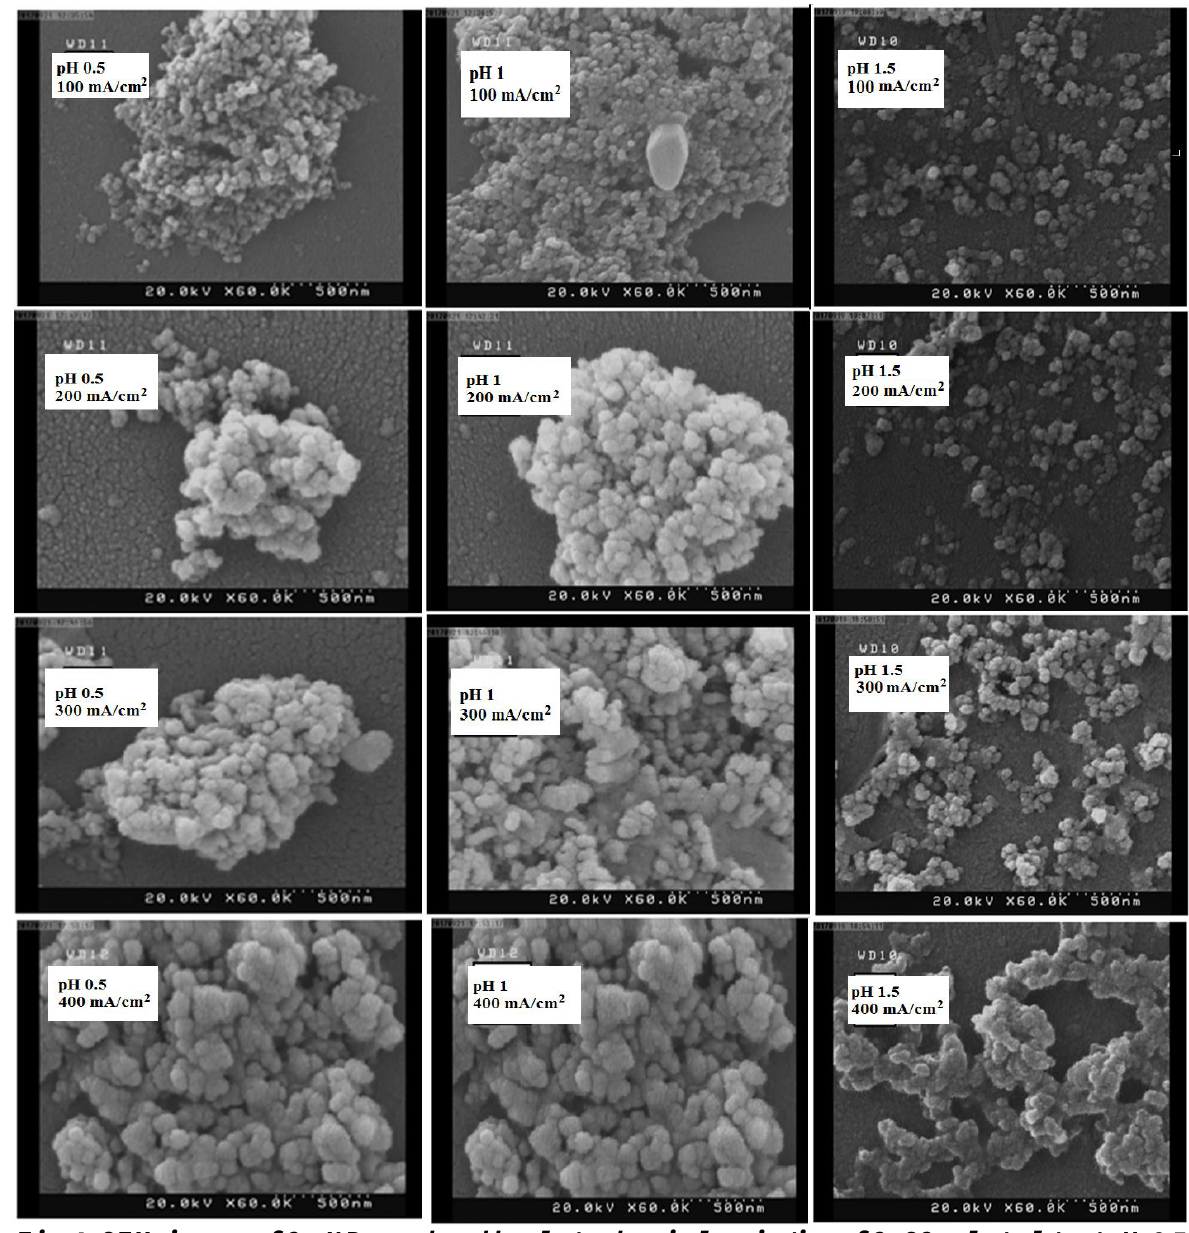
Fig. 4: SEM images of Cu NPs produced by electrochemical sonication of CuSO 1 and 1.5 and different current density of 100, 200, 300, and 400 mA/cm 2 , for 1min with sonication power of 400W